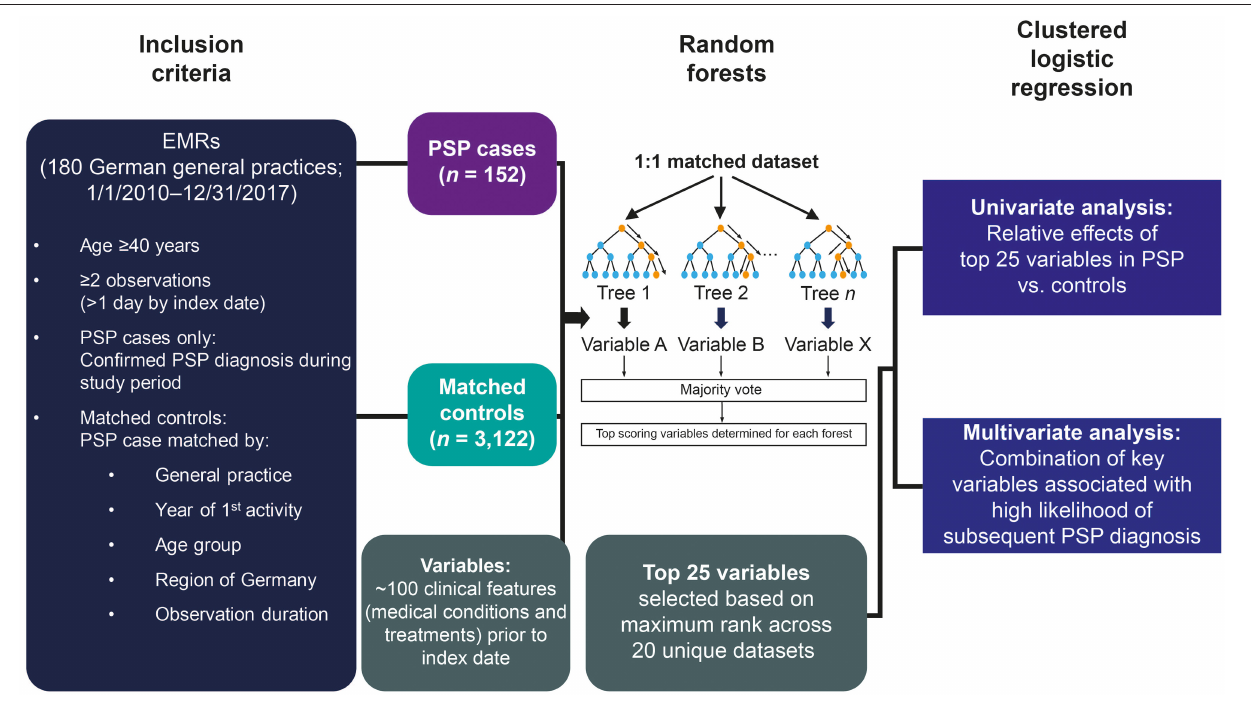
FIGURE 1 | Study design using a machine learning approach. EMR, electronic medical record; PSP, progressive supranuclear